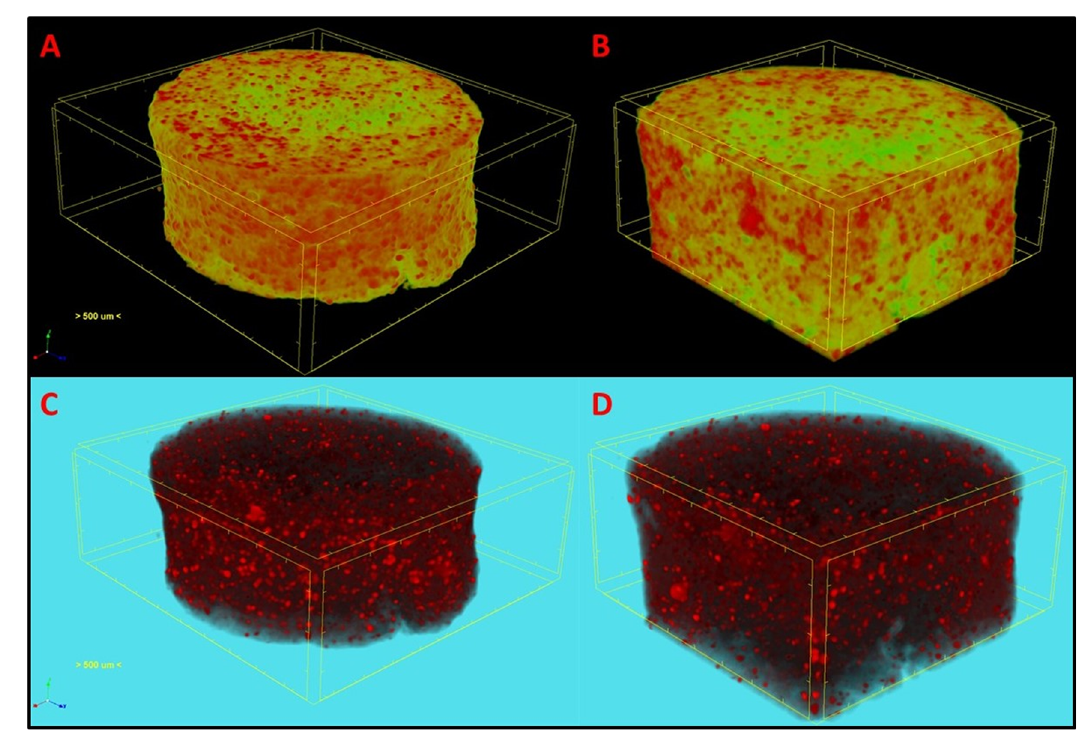
Fig. 2 Three-dimensional reconstructed micro-computed tomographic images of composite microspheres sintered scaffold showing homo- genous distribution of nHA particles (red) in green matrix ( A ) surface